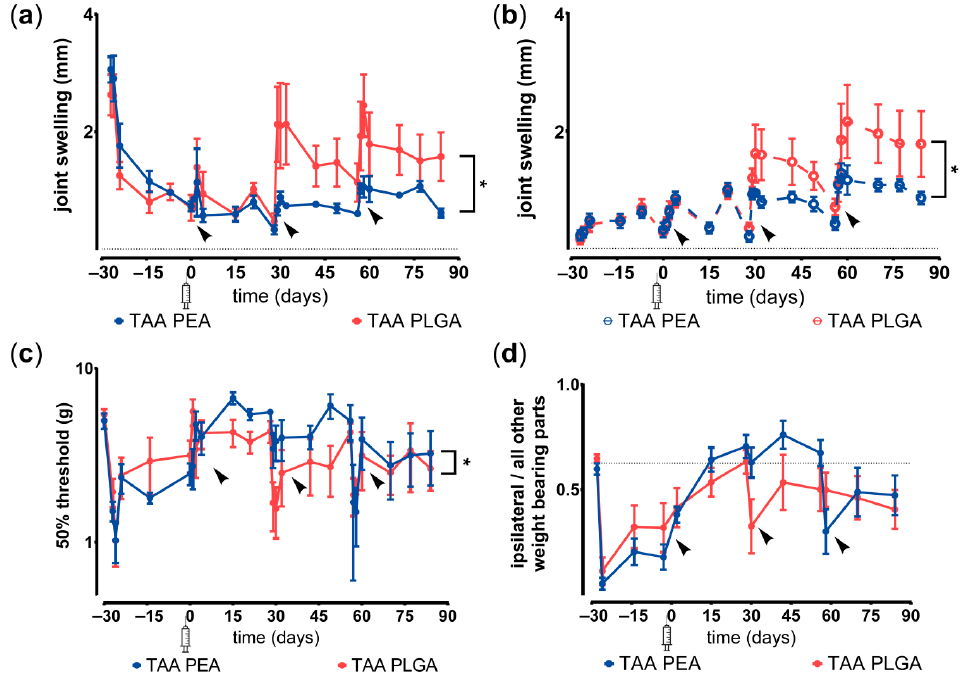
Figure 6. Anti-inflammatory and analgesic effects of TAA-loaded PLGA and PEA microspheres. ( a ) Joint swelling, as sign of inflammation, of the affected knee joints and ( b ) contralateral knee joints after single intra-articular injection of TAA-loaded PLGA (red) or TAA-loaded PEA microspheres